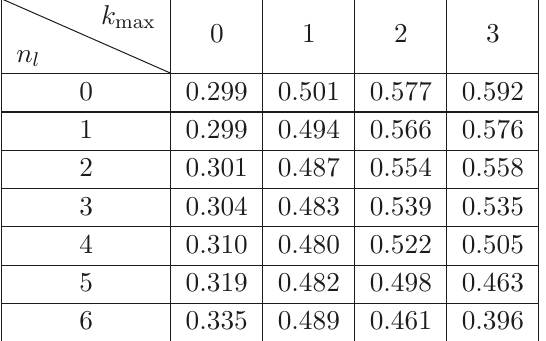
Table 1 . The values of N obtained from the truncated expression in eq. (2.23) for k max from 0 to 3, and for n l from 0 to